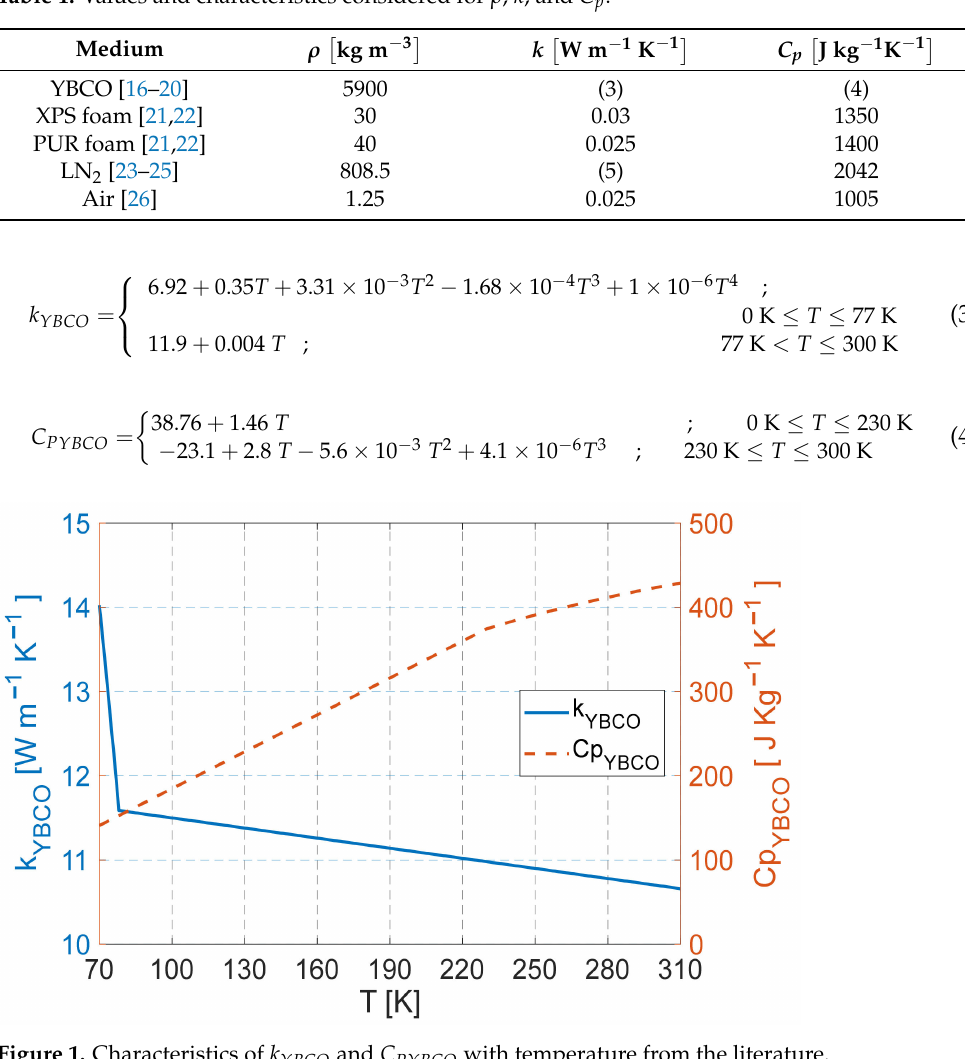
Figure 1. Characteristics of k YBCO and C PYBCO with temperature from the